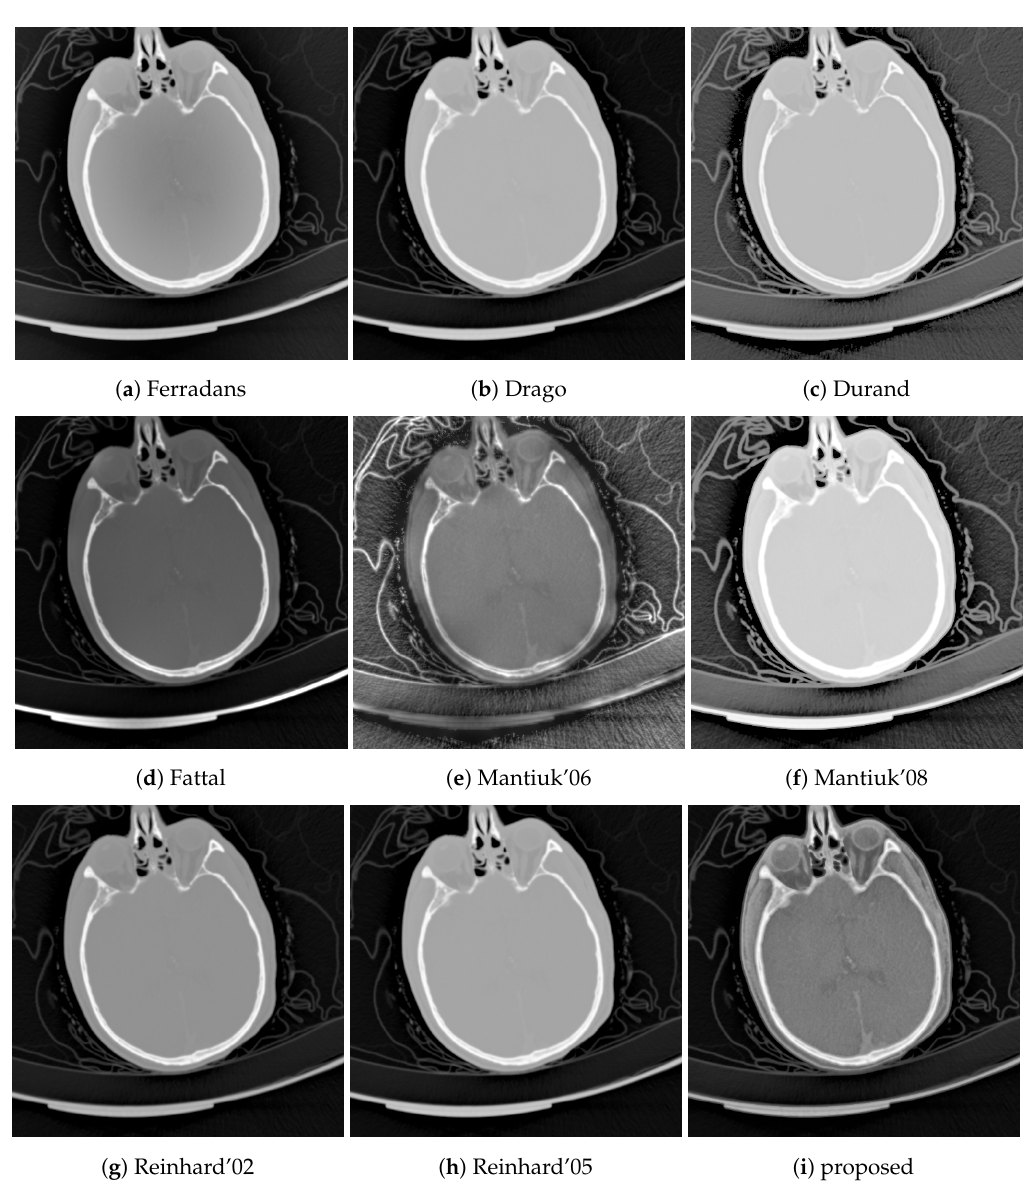
Figure 6. Tone mapped head CT scan with eight common operators and the proposed method. Parameters are summarized in Table 1; a quantitative comparison is presented in Table